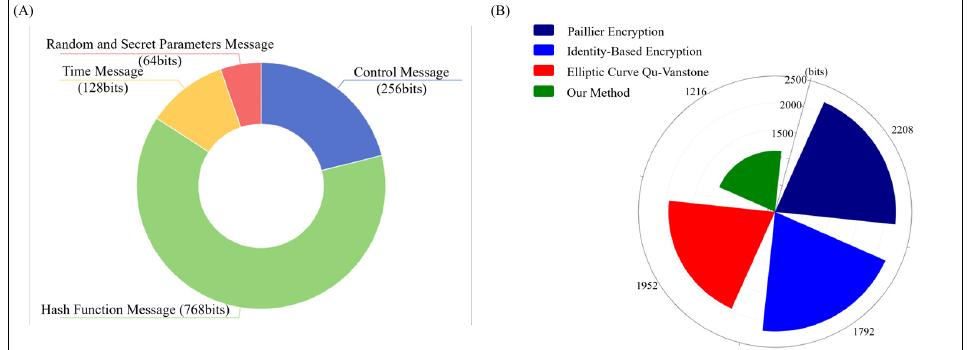
Figure 6. ( A ) Components of communication. ( B ) Communication cost comparison.